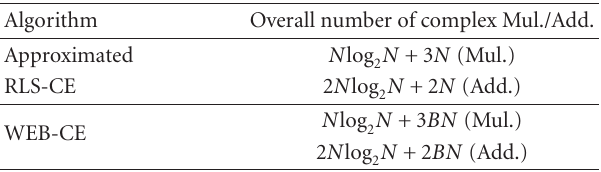
Table 1: Computational complexity of approximated RLS-CE and WEB-CE algorithms. Algorithm Overall number of complex